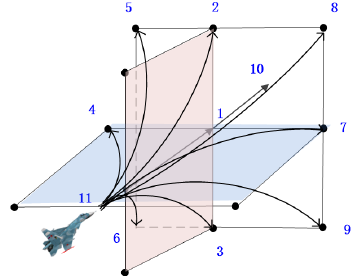
Figure 2. Diagram of fighter